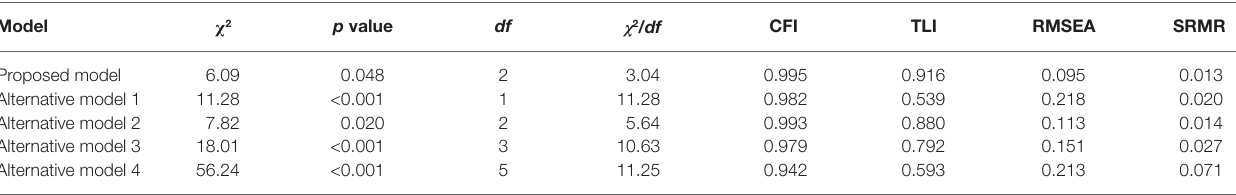
TABLE 2 | Model fit comparison between the proposed model and the alternative